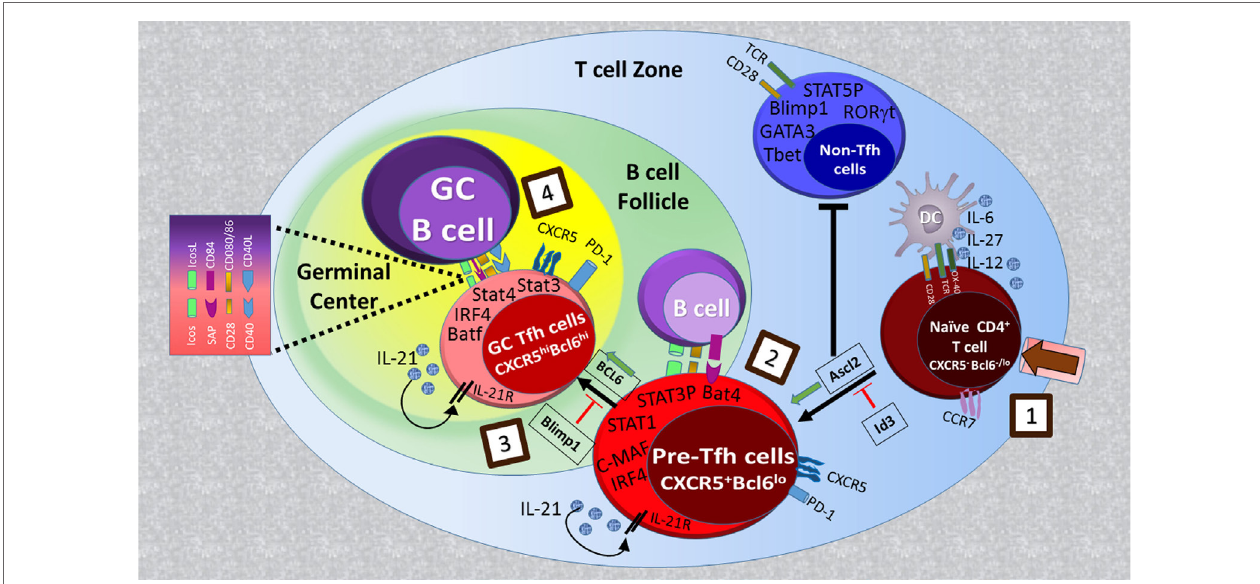
FigURe 1 | Regulatory signaling for T follicular helper (Tfh) cell development: naïve CD4 + T cell priming by MHC/antigen interaction on DCs (step 1) leads to the generation of CXCR5 + Bcl6 lo pre-Tfh cells with increased activity of transcriptional factors such as Achaete-scute homolog 2 (Ascl2), signal transducers and activators of transcription (STAT)1, STAT3, IFN-regulatory factor 4 (IRF4), and Batf (step 2). Ascl2 expression in activated T cells orchestrates them to migrate toward B cell follicles by upregulation of CXC chemokine receptor 5 (CXCR5) expression and repressing IL-2R-Blimp1 pathway as well as Th1, Th2, and Th17 cell differentiation. Upon interaction with cognate B cells at T-B border (step 3), CXCR5 + T cells begin to upregulate B-cell lymphoma 6 protein (Bcl6) expression, which in cooperation with other transcription factors determines the final differentiation state of Tfh cells within germinal centers (step 4).